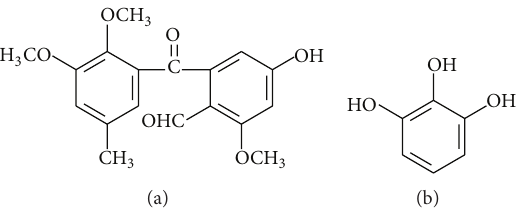
Figure 5: Chemical structures of (a) daldinal and (b) pyrogallol.